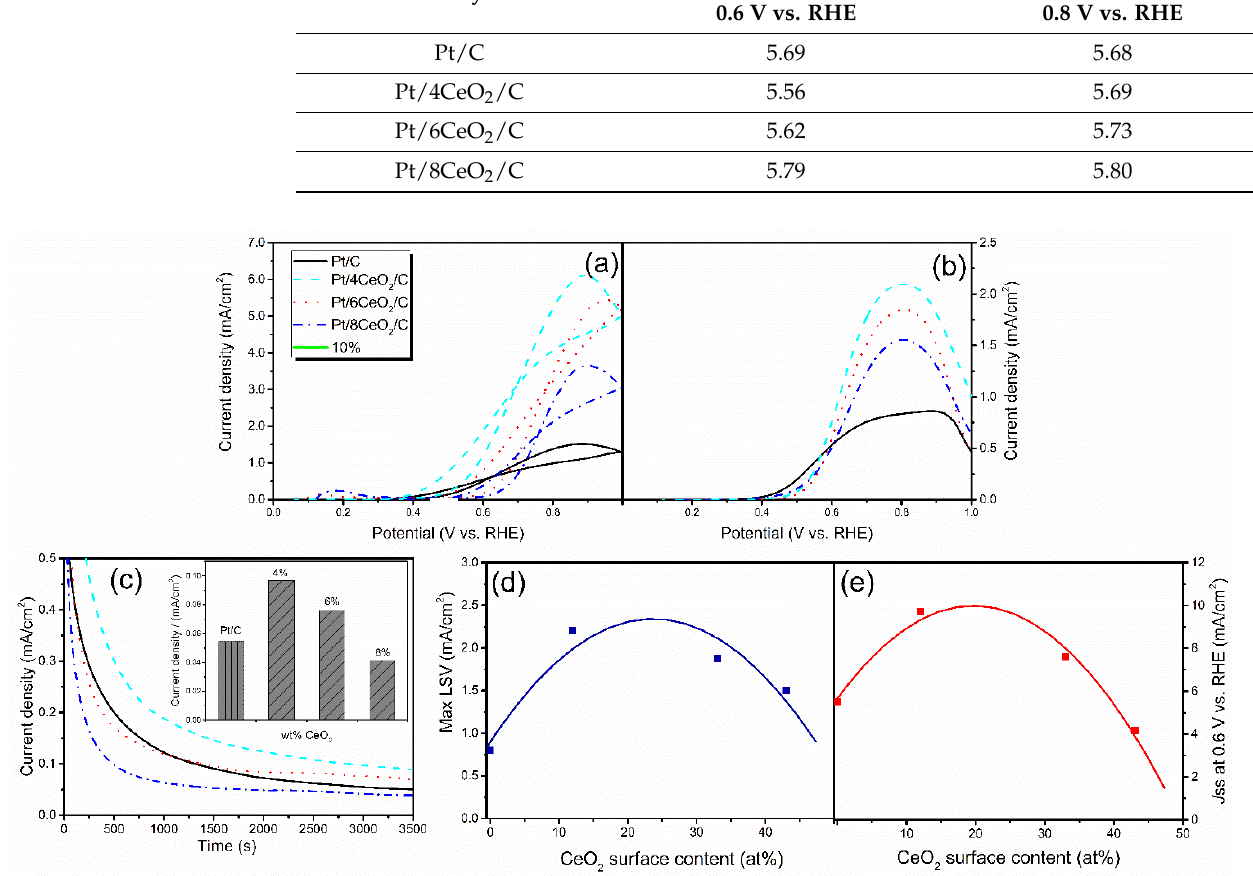
Figure 7. Cyclic voltammetry ( a ), linear sweep voltammetry ( b ), and chronoamperometry at 0.6 V vs. RHE ( c ), curves for ethanol oxidation for the Pt/CeO 2 /C and Pt/C catalysts with the current density expressed in terms of the ECSA. Inset ( c ): histogram of the steady state current density. Dependence of J max by LSV ( d ), and J ss by CA ( e ), on CeO 2 content on the catalyst surface.